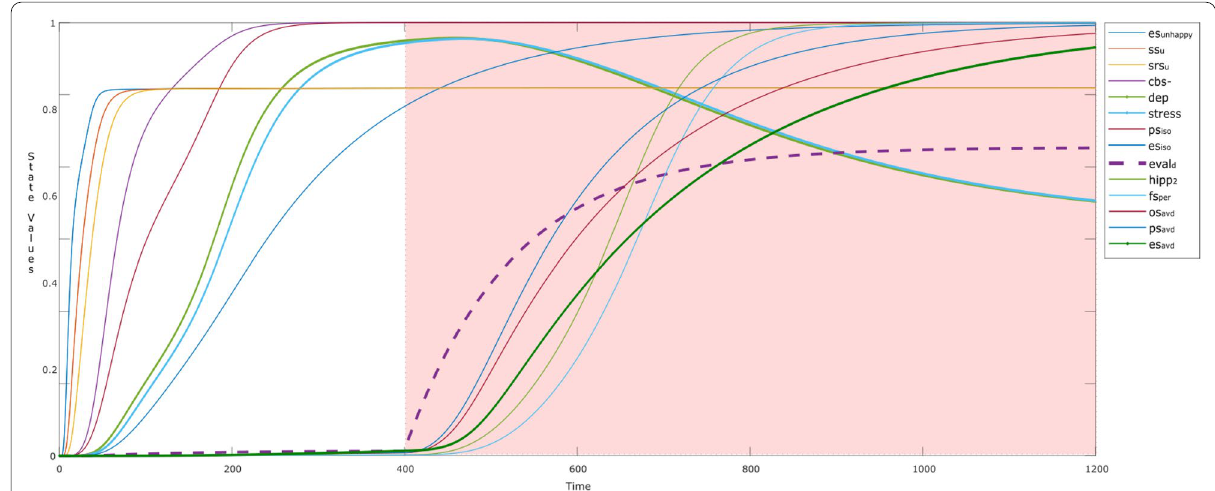
Fig. 11 Coping behaviors reduce stress and depression/anxiety caused by narcissistic